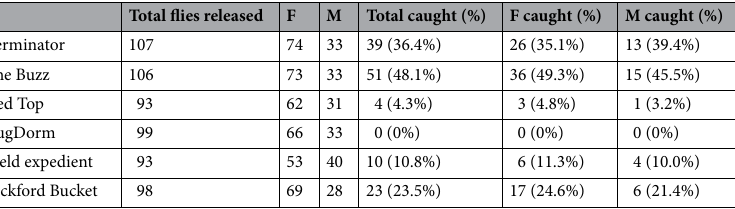
Table 1. Total M. sorbens caught by pilot laboratory testing of possible traps. The number of flies introduced into the testing cage varied slightly due to deaths during acclimatisation. F females, M males.